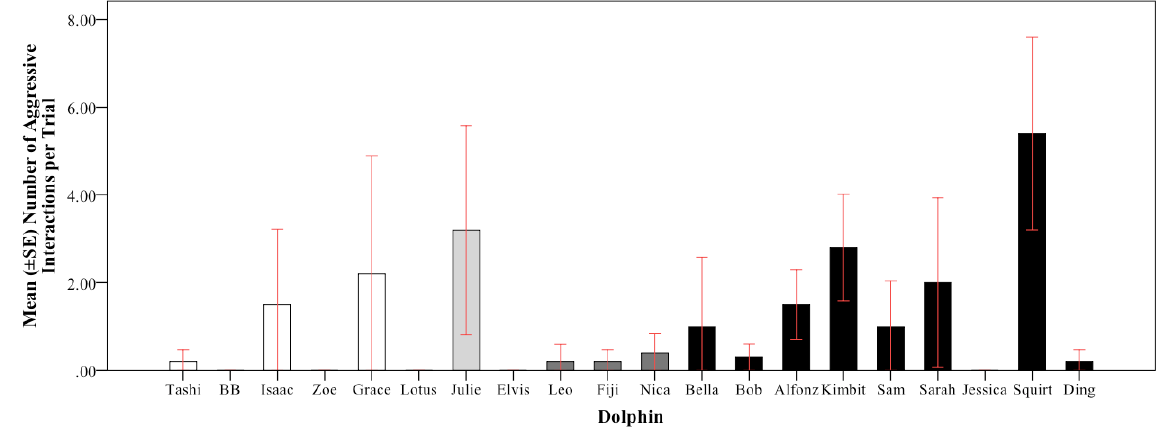
Figure 4. Mean (± 1 SE) number of aggressive interactions with the apparatus per trial ( n = 10) exhibited by each subject ( N = 30) and age class (calf = white, juvenile = light grey, subadults = dark grey, and adults = black).